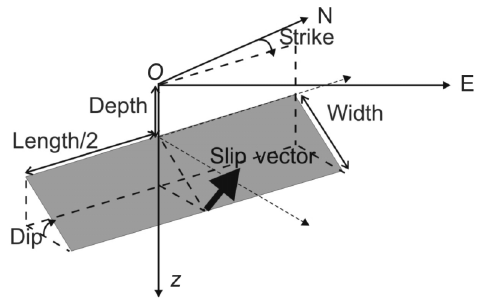
Fig. 2. The Okada source: a fault occurring in ho- mogeneous and isotropic elastic half-space with a uniformly magnetized upper layer. Depth is the dis- tance between the origin O and the upper edge of the fault; strike is the orientation of the fault with respect to the north; dip is angle of the fault plane with re- spect the horizontal plane; length and width are the length and width of the fault respectively; slip is the vector of the